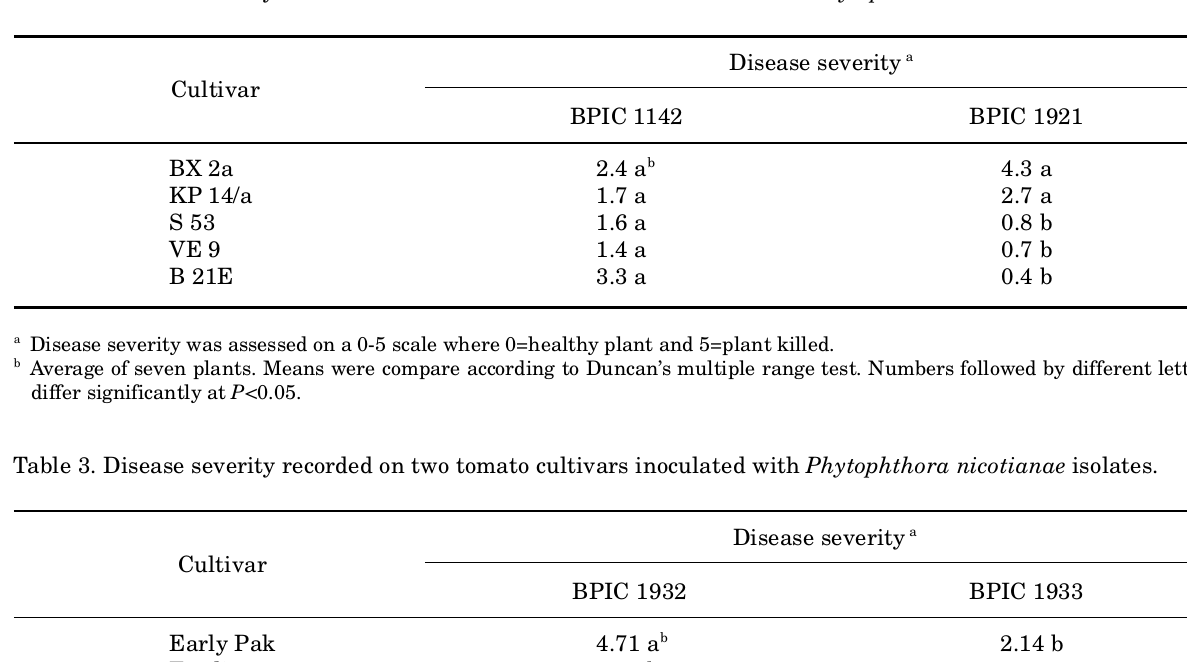
Table 2. Disease severity recorded on five tobacco cultivars inoculated with Phytophthora nicotianae isolates.